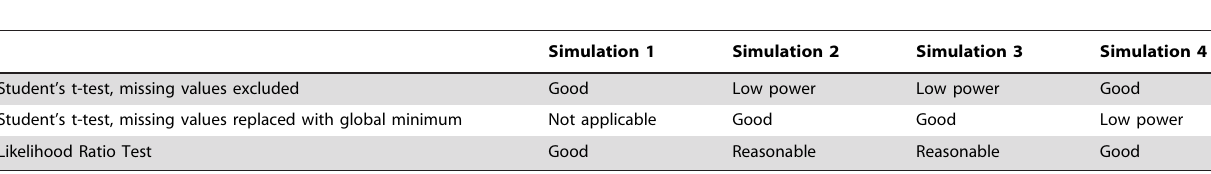
Table 6. Compares the performance between four simulation